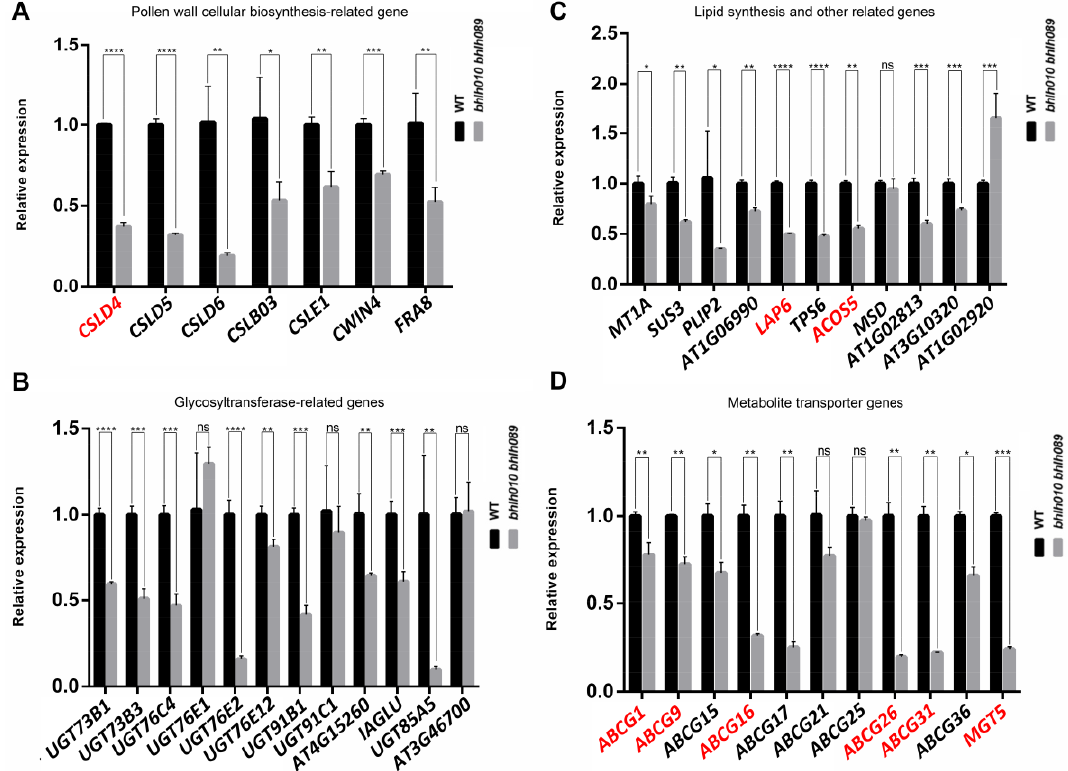
Figure 5. Detection of the expression of genes related to bHLHs that may regulate pollen wall development. ( A – D ) The expressions of pollen wall development-related genes were examined in the WT and the bhlh010 bhlh089 double mutants. ( A ) Different genes related to pollen wall cellulose synthesis were detected by qRT-PCR. ( B ) Different genes related to glycosyltransferase-related genes were detected by qRT-PCR. ( C ) Different genes related to lipid synthesis and other pathways were detected by qRT-PCR. ( D ) Different genes related to metabolite transport were detected by qRT-PCR. The red font indicates validated genes associated with pollen wall development. Actin gene served as the reference. The asterisks indicate a statistically significant difference (*, p < 0.05; **, p < 0.01; ***, p < 0.001; ****, p < 0.0001, ns indicates no significant difference). Error bars indicate SD. Experiments were performed at least three independent times. Genes marked in red have been reported to be involved in pollen wall formation. In addition, SUS3 , PLIP2 , LAP6 , AT1G06990 , TPS6 , ACOS5 , and AT1G02813 were sig- nificantly downregulated in the anther of bhlh010 bhlh089 (Figure 5C). SUS3 is known to play an important role in sucrose metabolism (Angeles-Nunez and Tiessen, 2010; Angeles- Nunez and Tiessen, 2012), PLIP2 is a glycerolipid A1 lipase and is regulated by hormone signaling [91], AT1G06990 encodes a GDSL motif – containing lipase [92], TPS6 is highly expressed in inflorescence and participates in the synthesis of trehalose [93], and ACOS5 and LAP6 are key genes regulating the development of the pollen exine [31,32,81]. The ABC transporter family is likely to be involved in the process of small-molecule metabolite transport and the formation of the pollen exine and intine. ABCG1 , ABCG16 , ABCG26 , and ABCG31 that have been reported to be involved in the development of pollen exine [37,39,42] were confirmed to be significantly downregulated in bhlh010 bhlh089 anthers (Figure 5D). 2.6. The CSLB03 Gene Is a Direct Downstream Target of bHLH010 To further verify the possibility that some of the above enzymes or transporter genes were directly activated by bHLH010 or/and bHLH089, we performed dual-luciferase tran- scriptomic activation activity assay. Among the detected candidate genes, the expressions of CSLD5 , CSLD6 , UGT85A5 , SUS3 , AT1G02813 , and CSLB03 were found to be directly